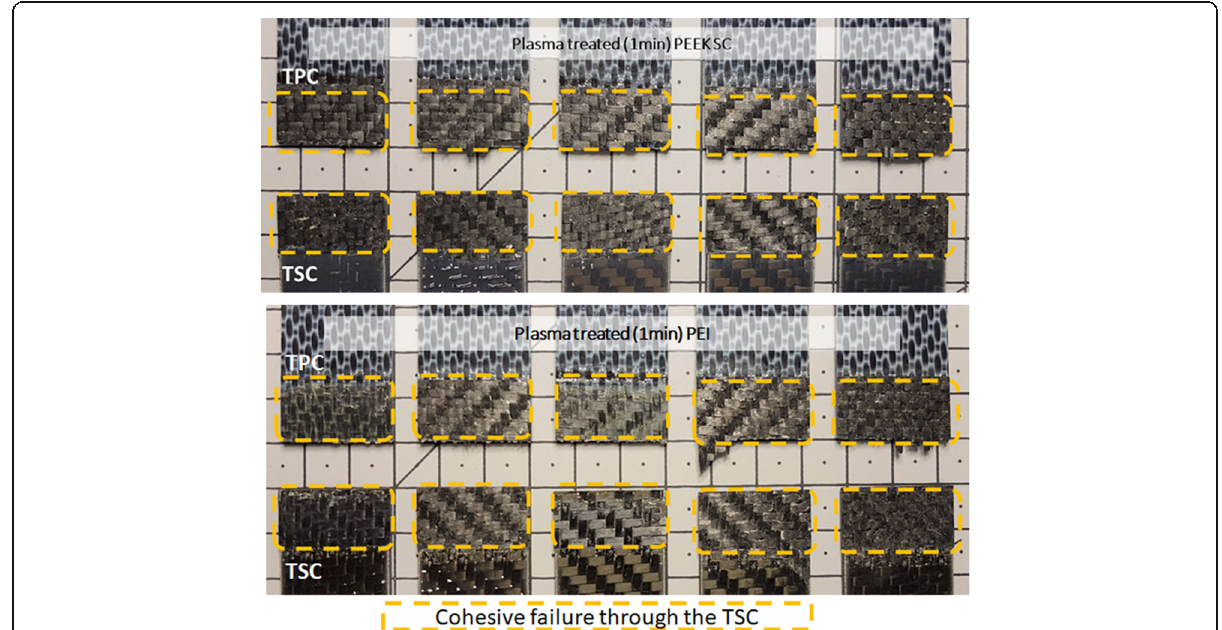
Fig. 15 Failure mode analysis on plasma treated PEEK SC and PEI interlayers in welded